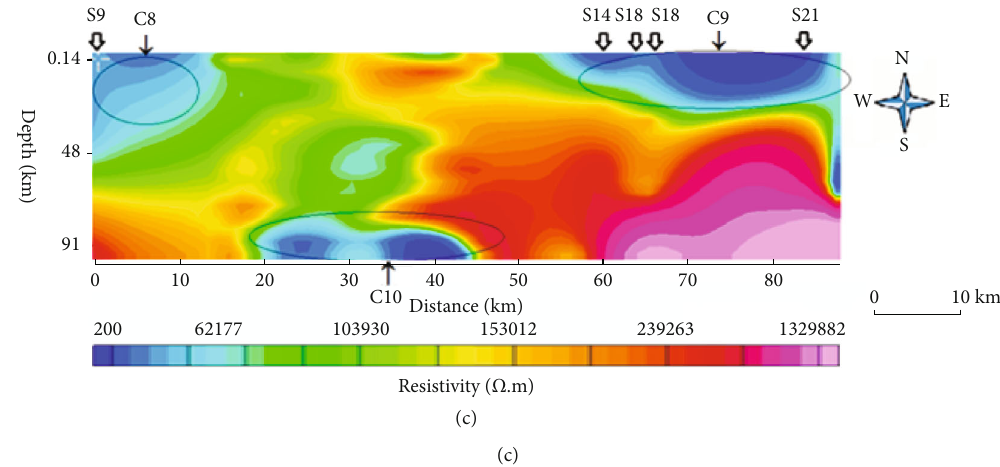
Figure 15: (a) Overlay of P4 pro fi le on LST. (b) 2D resistivity section of pro fi le P4. (c) 2D resistivity section of P5 pro fi